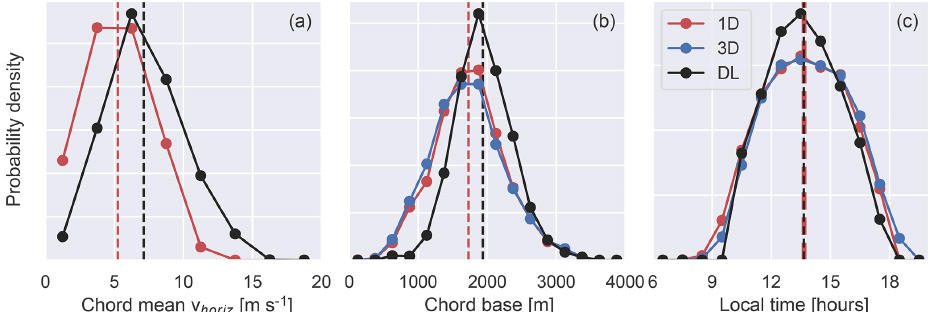
Figure 5. Probability density of the mean horizontal wind speed below the chord (a) , chord-base height (b) , and time of day (c) of all chords detected from the Doppler lidar, the 1D column output, and the 3D snapshots. The dashed vertical lines mark the mean values. Since the mean time of day is almost identical (13.66 vs. 13.65) the one line was plotted thicker for visibility.